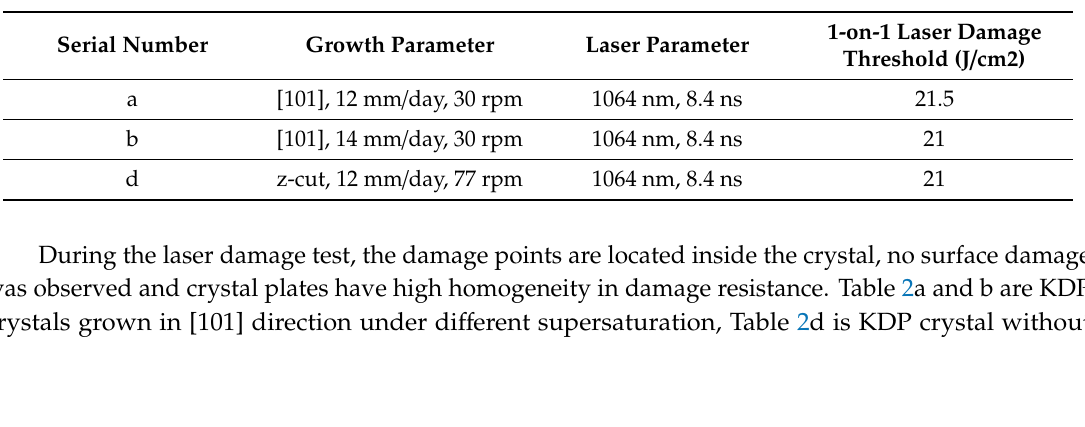
Table 2. One-on-one laser damage threshold of di ff erent orientation KDP